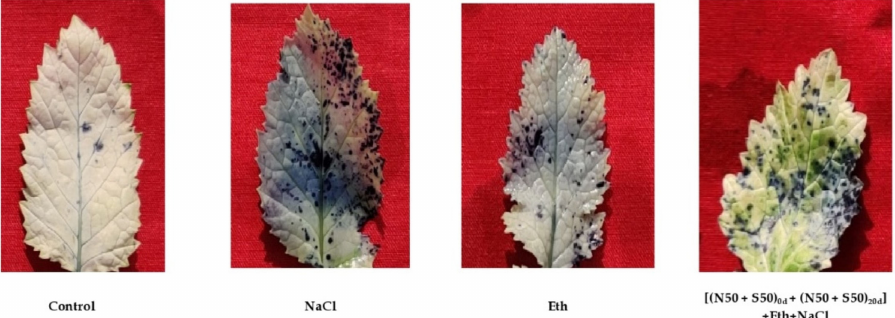
Figure 2. In situ determination of generated levels of superoxide ion (O 2 •− ) through nitro blue tetrazolium staining in mustard after dehydration of leaves at 40 DAS. Plants were raised with 0.1 mM NaCl alone or in combination with 200 µ L L − 1 ethephon (Eth) with split dosage of N and S [(N50 + S50) 0d + 20d